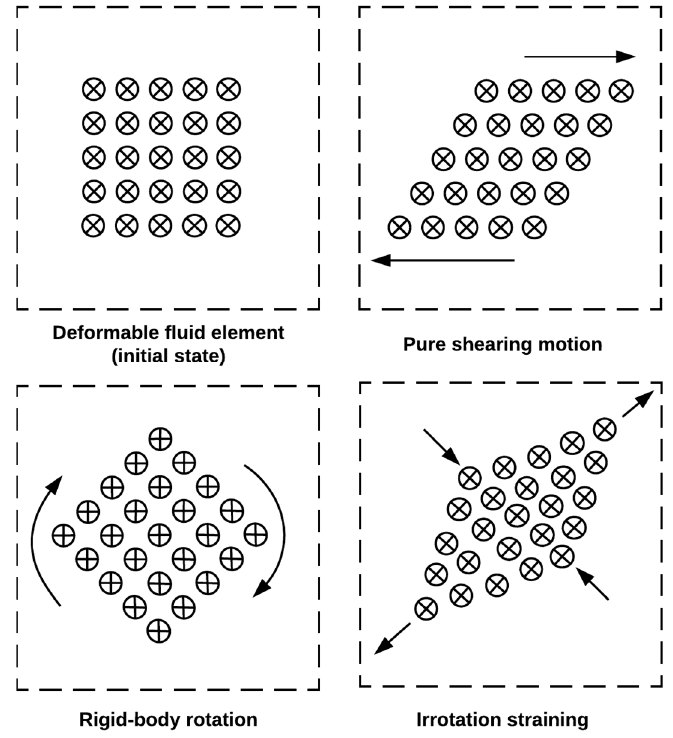
Figure 6. A qualitative model of three elementary motions of a flow [29].